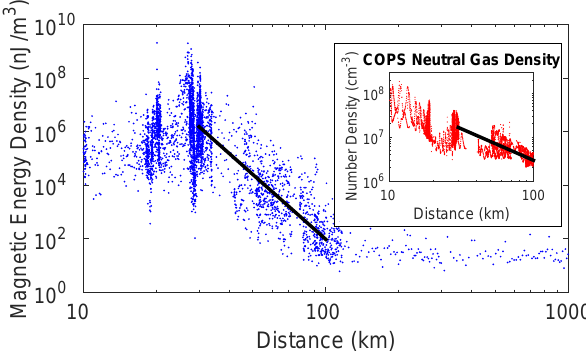
Figure 3. Radial variation in the magnetic energy density of the low-frequency wave activity in the spectral range 30–80mHz. The inset shows the radial variation in the density of cometary neutrals as measured by the neutral gas monitor COPS of the ROSINA in-